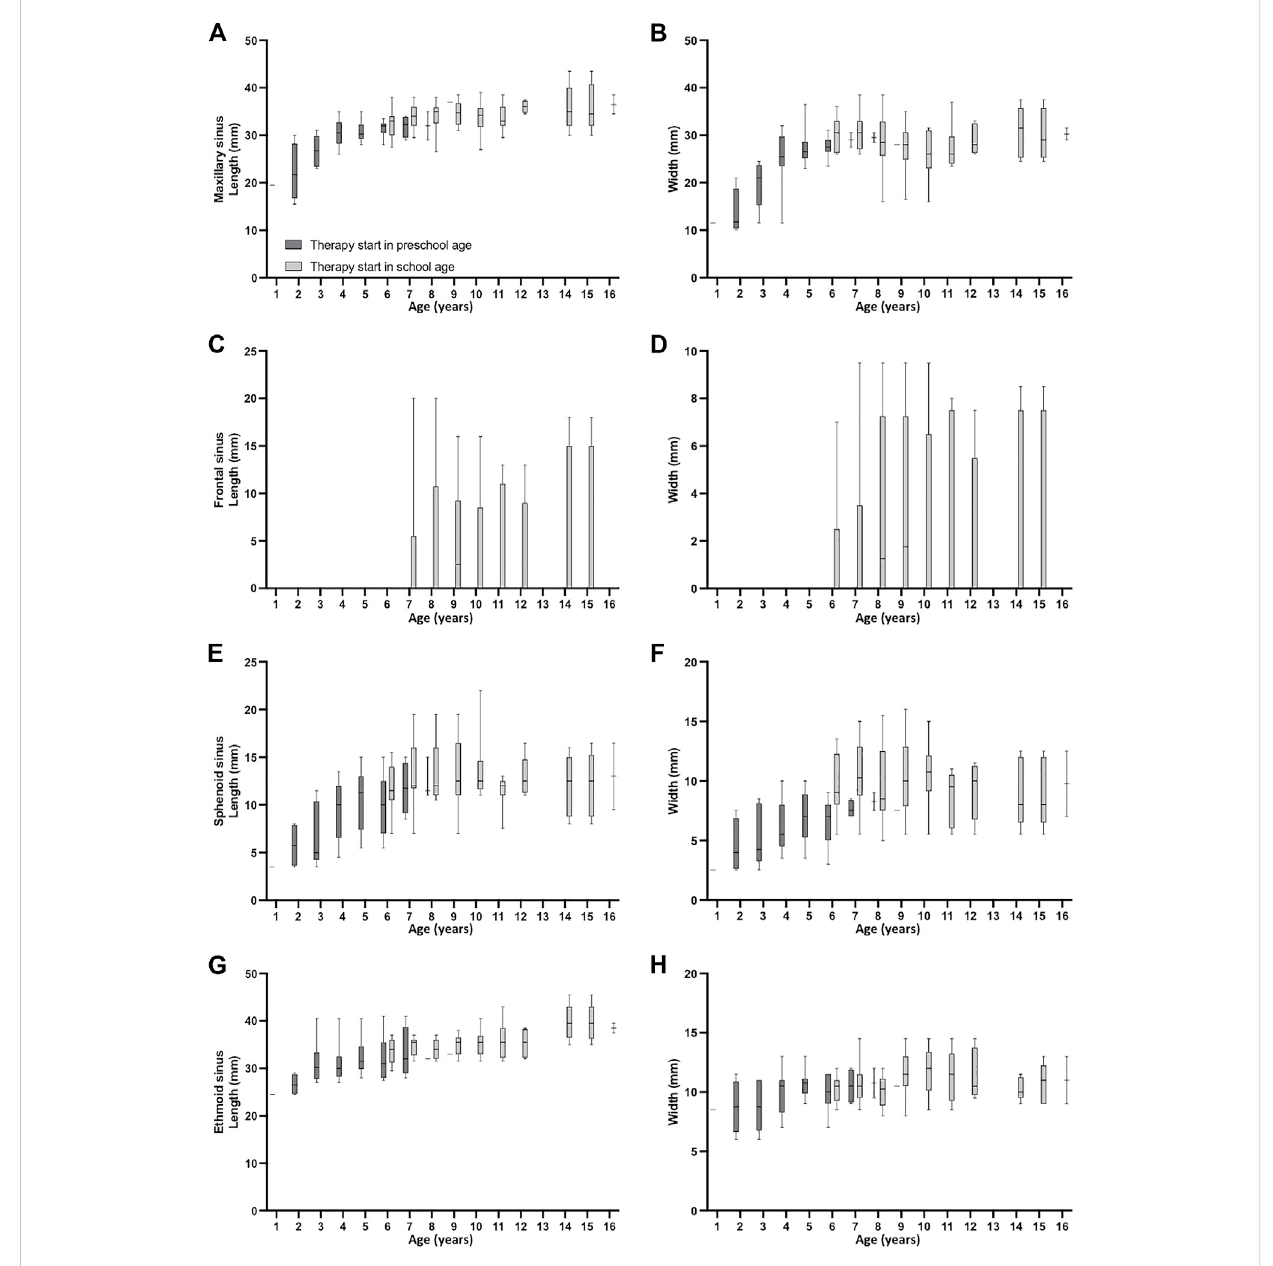
FIGURE 2 Development of paranasal sinus dimensions before (MRI1) and under therapy with lumacaftor/ivacaftor (MRI2-5) in children with cystic fi brosis starting lumacaftor/ivacaftor therapy in preschool and school age. Measurements of the dimensions of the maxillary (A, B) , frontal (C, D) , sphenoid (E, F) and ethmoid (G, H) sinus. Both sides were averaged per patient. Boxes represent 25th to 75th percentile, the median is indicated by a horizontal line, and whiskers mark 5th and 95th percentiles. Spearman correlation coef fi cients r with p -values for dimensions vs. age are indicated in each